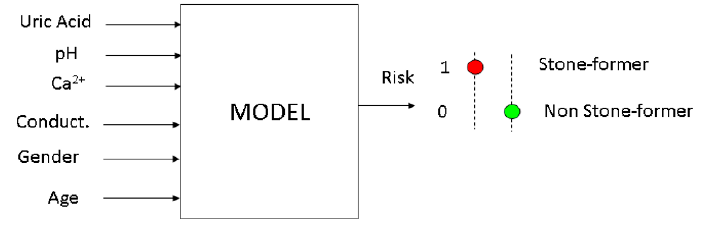
Figure 17. Artificial intelligence model inputs and output.